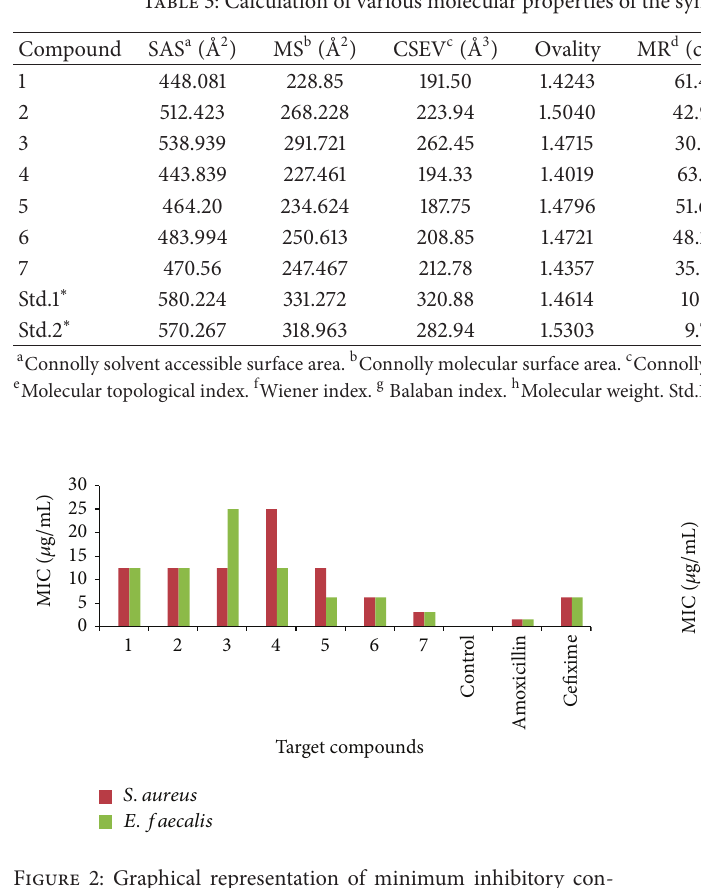
Figure 3: Graphical representation of minimum inhibitory con- centration (MIC) of benzamide substituted Mannich bases against Gram negative bacterial